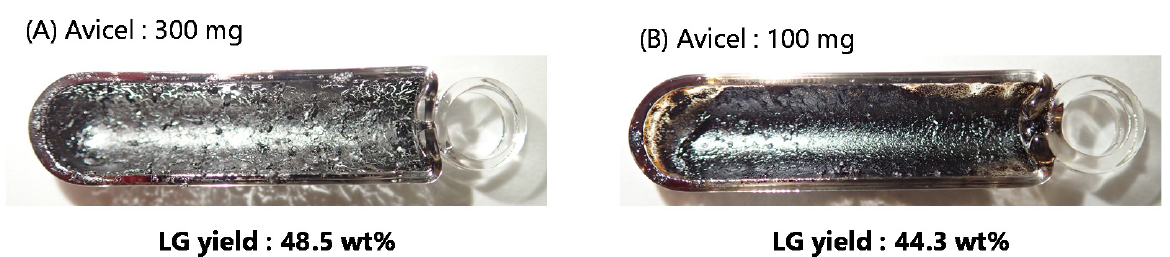
Figure 11. Photographic images of quartz boats after applying IR radiation to ( A ) 300 mg and ( B ) 100 mg Avicel cellulose samples (1 kW, 5 L/min nitrogen flow, 30 s).